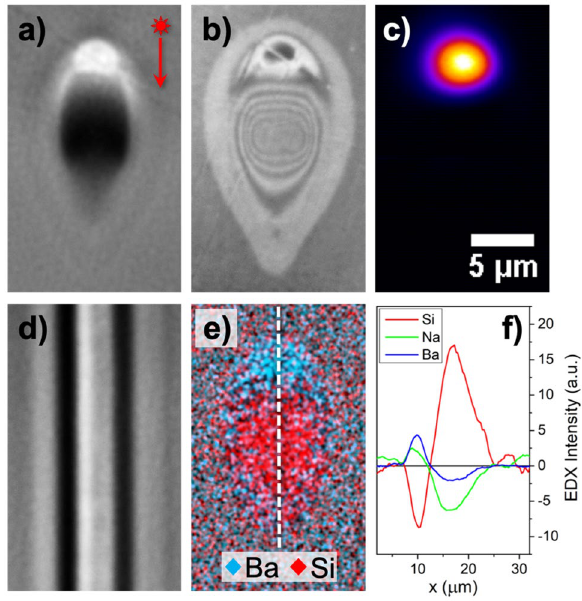
Figure 1. Characterization of optical waveguides produced with 530 nJ pulses and UO lens focusing at 250 µm of depth. ( a ) Transmission and ( b ) reflection cross-section optical microscopy, ( c ) near field image of the guided mode at 1640 nm, ( d ) longitudinal (top view) optical microscopy, ( e ) EDX elementary mapping and ( f ) EDX profile measured along the vertical line indicated in ( e ). Scale bar on ( c ) applies to all images. Laser beam direction is indicated by the red arrow in ( a